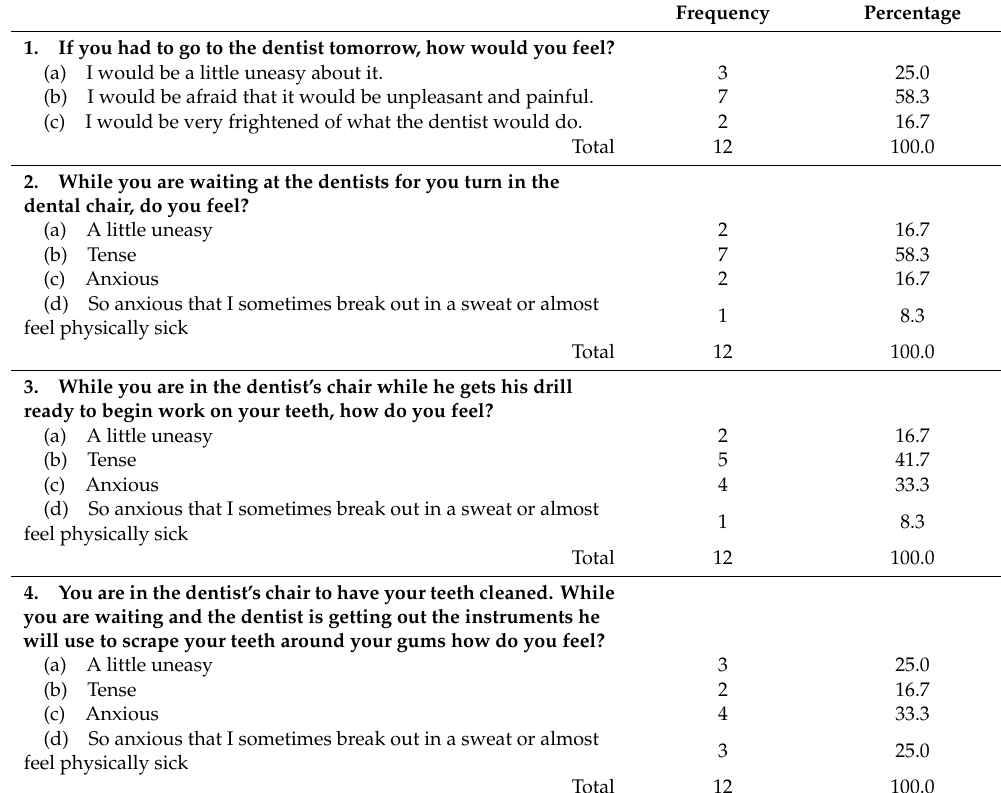
Table A1. Frequencies and percentages of the answers given per item of the CDAS [26]